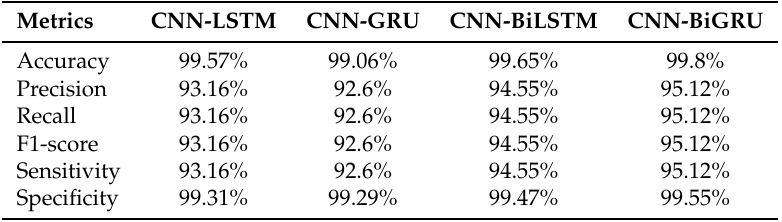
Table 2. Performance evaluation results for the hybrid